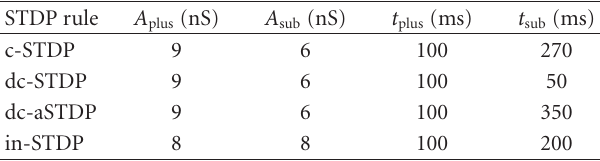
Table 1: The parameters for optimal synchronization